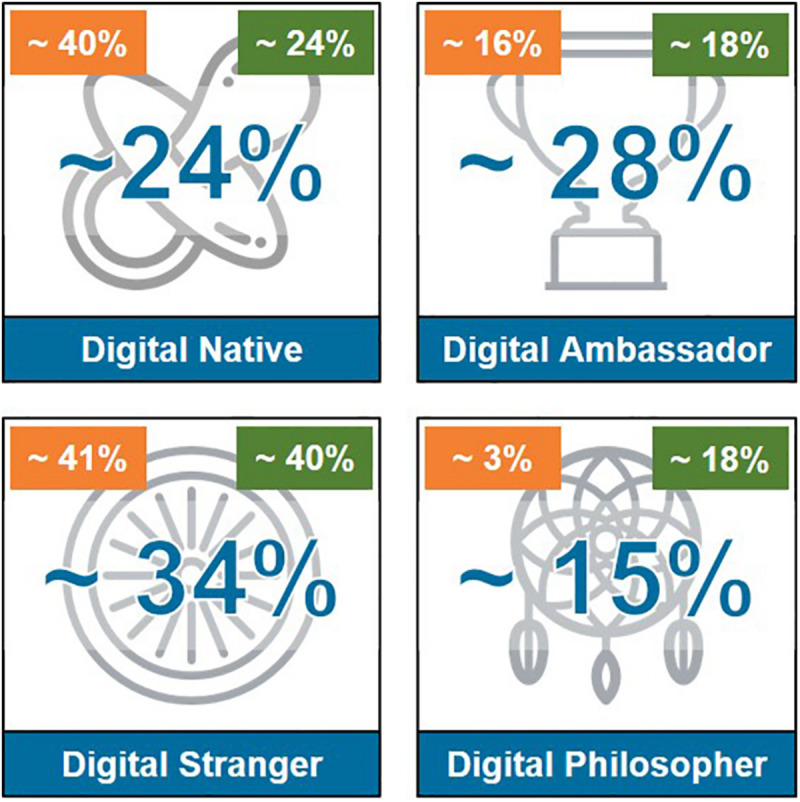
Digital Profile Map.